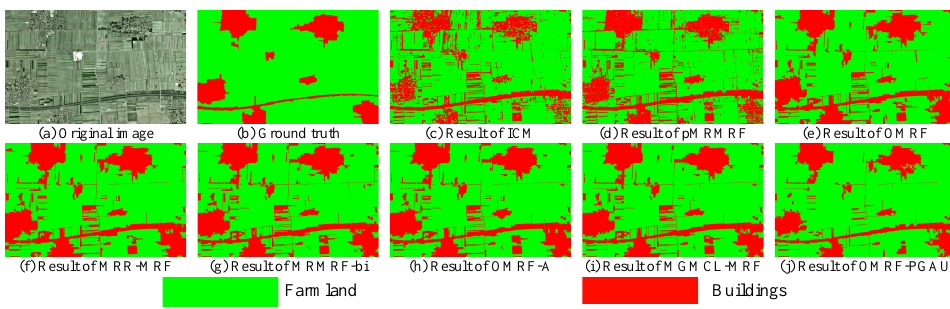
Figure 10. Semantic segmentation results for medium size SPOT5 image.